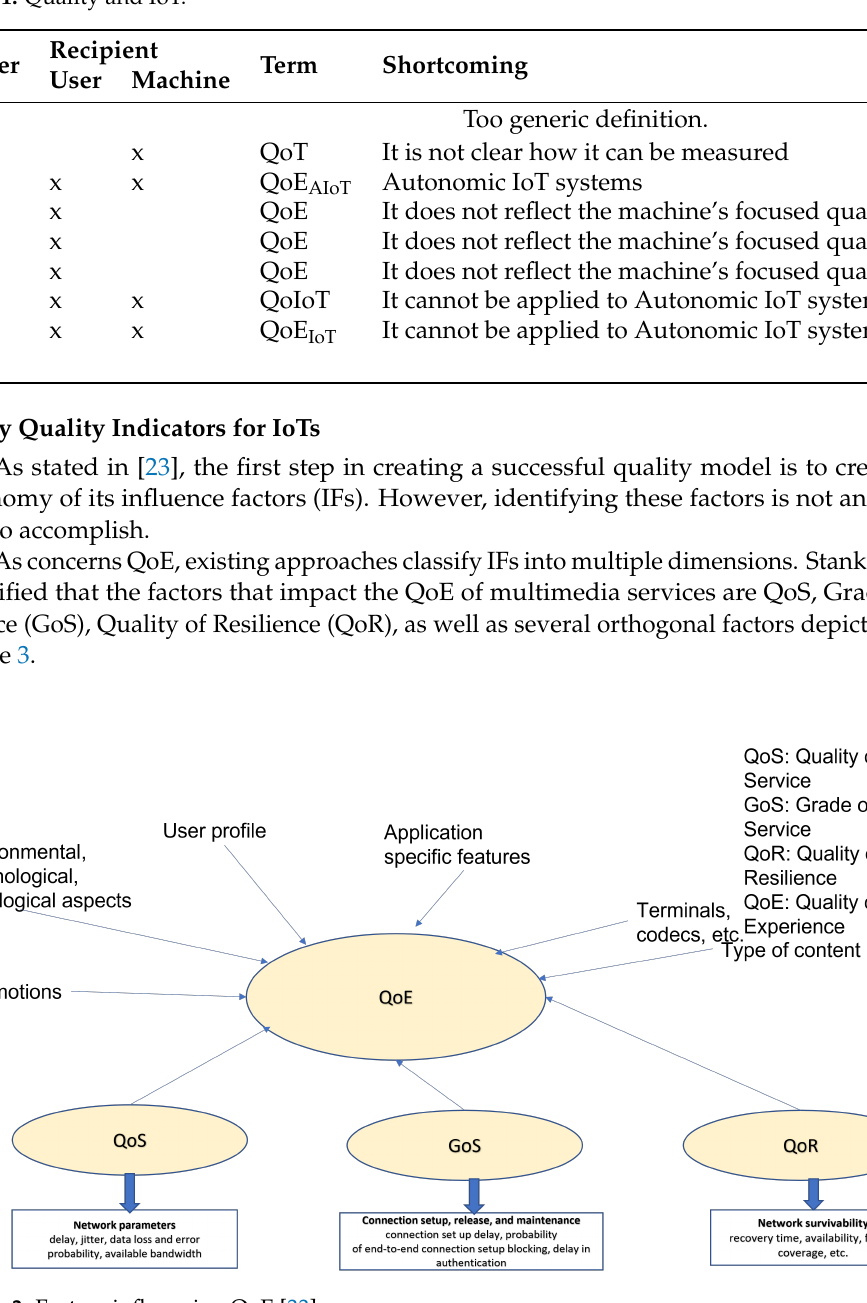
Table 1. Quality and IoT.